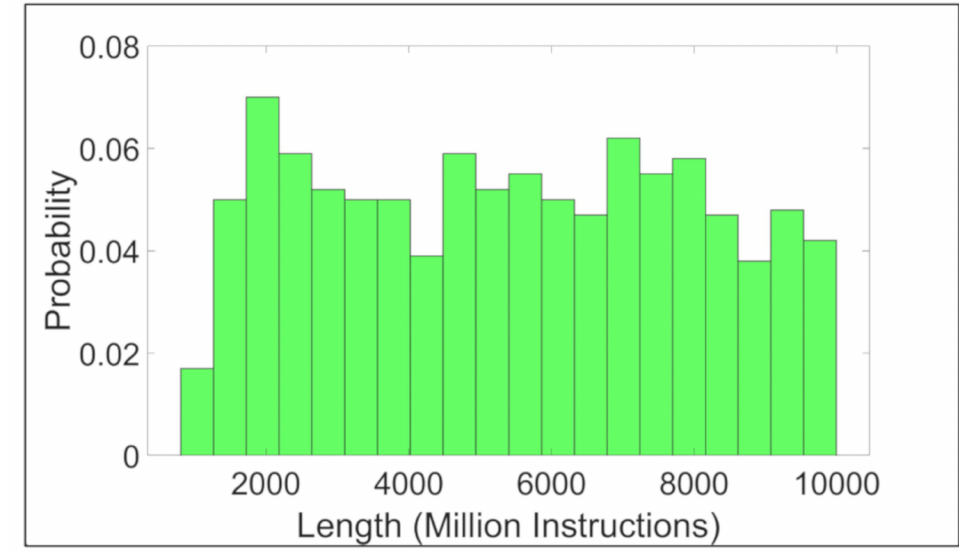
Figure 7. Probability distribution of the generated requests’ length